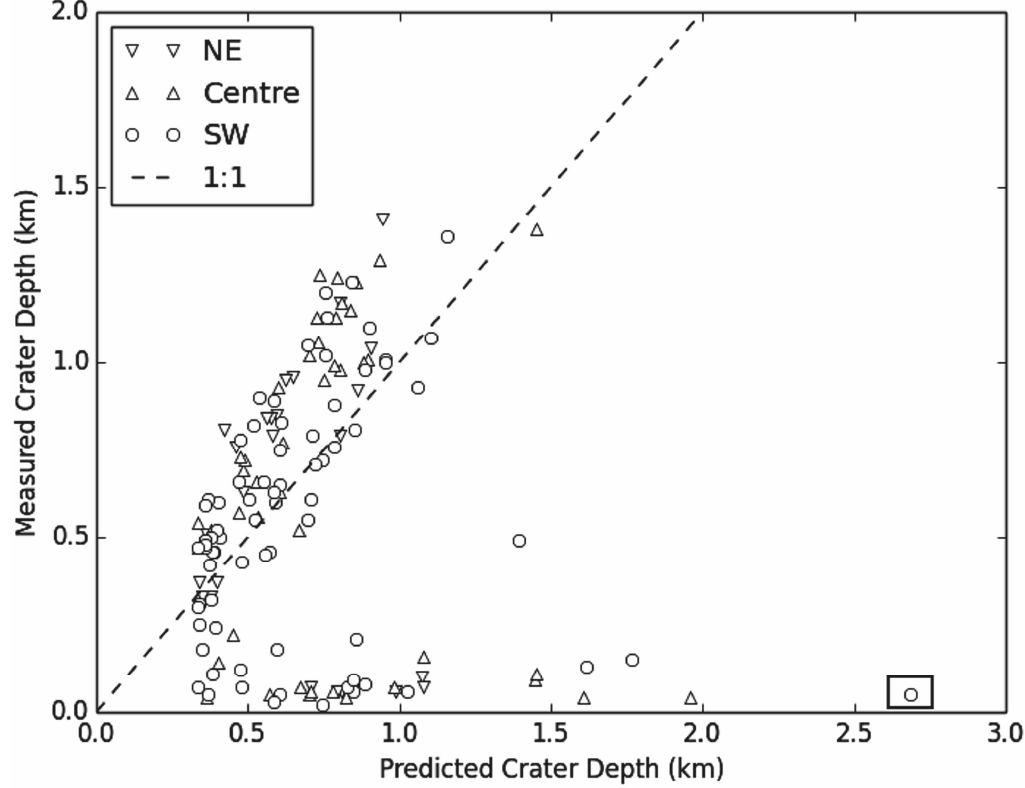
Figure 5. Measured depth vs. predicted depth diagram (MPD) of impact craters in Isidis Planitia. The dashed line is the 1:1 line (baseline), representing fresh craters. Symbols differ depending on whether the craters are located in the northeastern sector of Isidis Planitia (downward triangles), in the center (triangles), or in the southwestern sector (circles). The size of the data point symbols includes an estimated error of ±25 m of the measured depths (refer to Section 4). Most craters from all three locations are plotted along or very close to the baseline. Of those craters plotting close to the horizontal axis, the majority are from the central and southwestern sections of Isidis Planitia. The data point enclosed in the square ( x-y coordinates: 2.68, 0.05) corresponds to a feature designated as 13-000037 in [41]’s database. The diagram and its interpretation are discussed in the